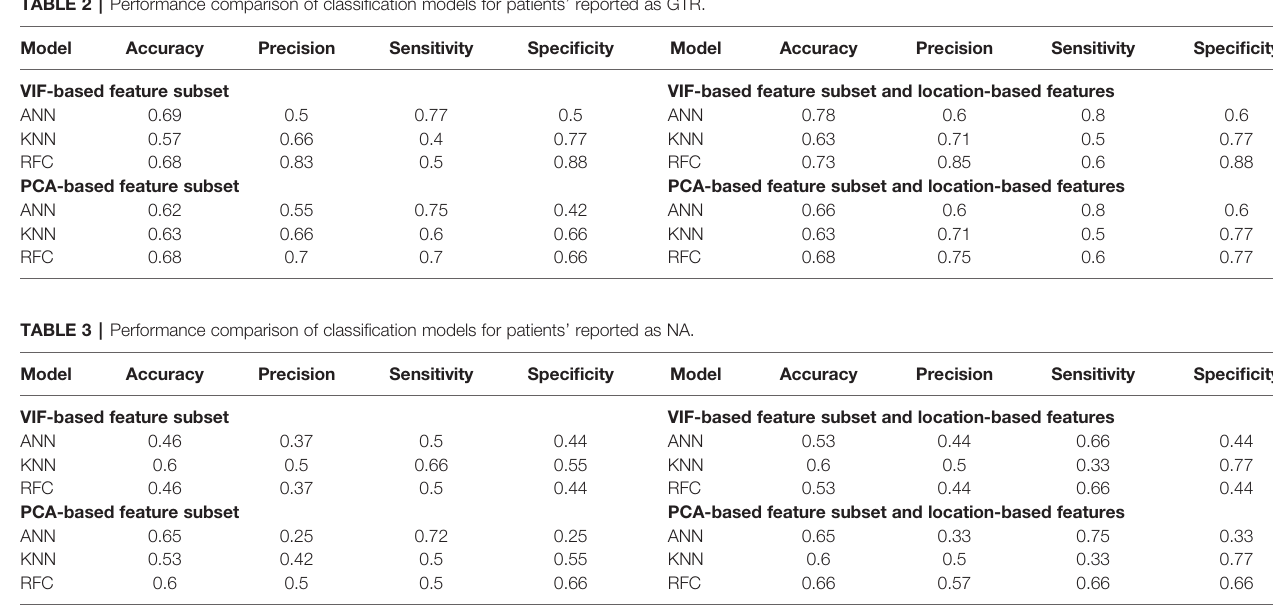
TABLE 2 | Performance comparison of classi fi cation models for patients ’ reported as GTR.